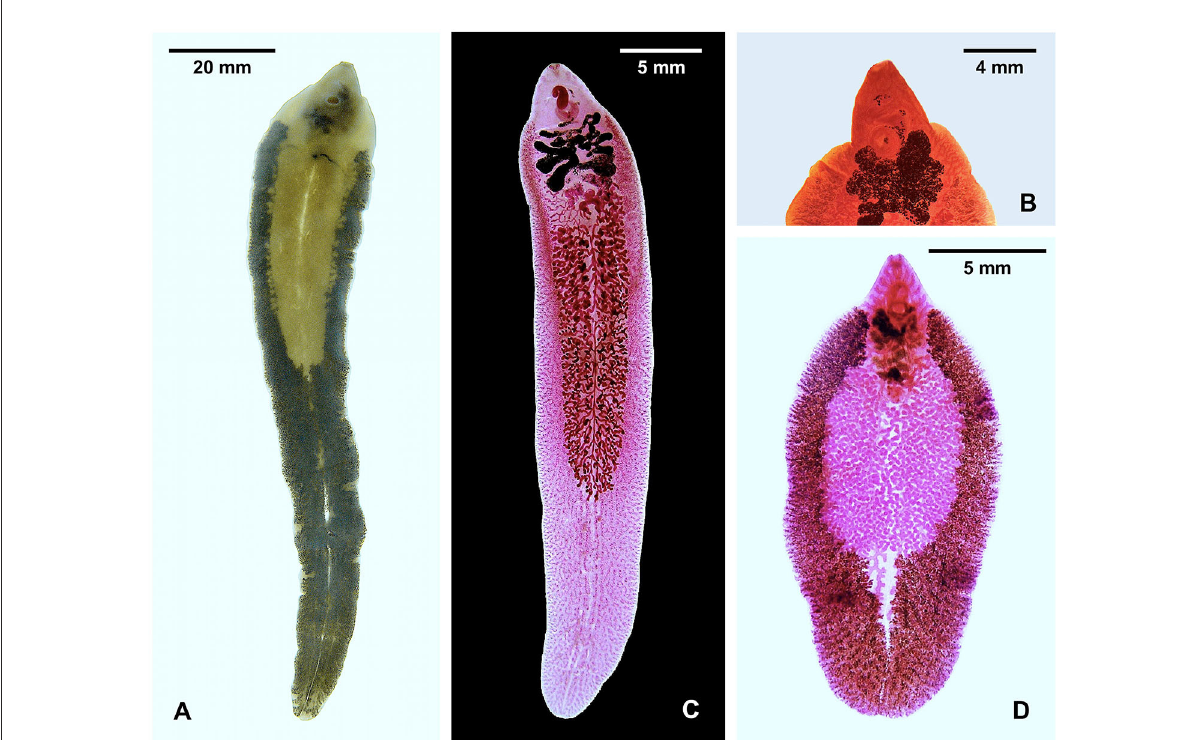
FIGURE1 Species of Fasciola . (A) Unstained F. nyanzae from hippopotamus in South Africa (note maximum width at the level of ovary). (B) Anterior part of stained F. nyanzae showing big apical cone and pronounced shoulders. (C) F. gigantica from cattle in Burkina Faso (note less pronounced shoulders and almost parallel lateral body walls). (D) Specimen highlighting the vitelline follicles of F. hepatica from sheep in Spain (note non-parallel lateral body walls). See decreasing distance between testis end and posterior extremity of the